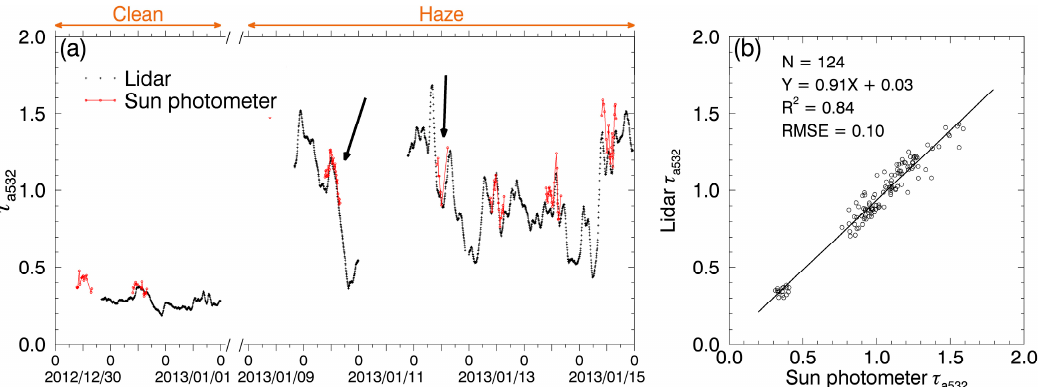
Figure 5. ( a ) Time series of lidar-derived and sun-photometer-measured aerosol optical depth (AOD) ( τ a ) at 532 nm for the entire period. The two black arrows in panel ( a ) indicate two examples of notable temporal variations of aerosol-loading during the haze period. ( b ) Scatterplot of concurrent lidar and sun photometer τ a measurements. Results from linear regression of them are annotated at the upper-left corner of panel ( b ) and indicate good agreement between the two datasets.